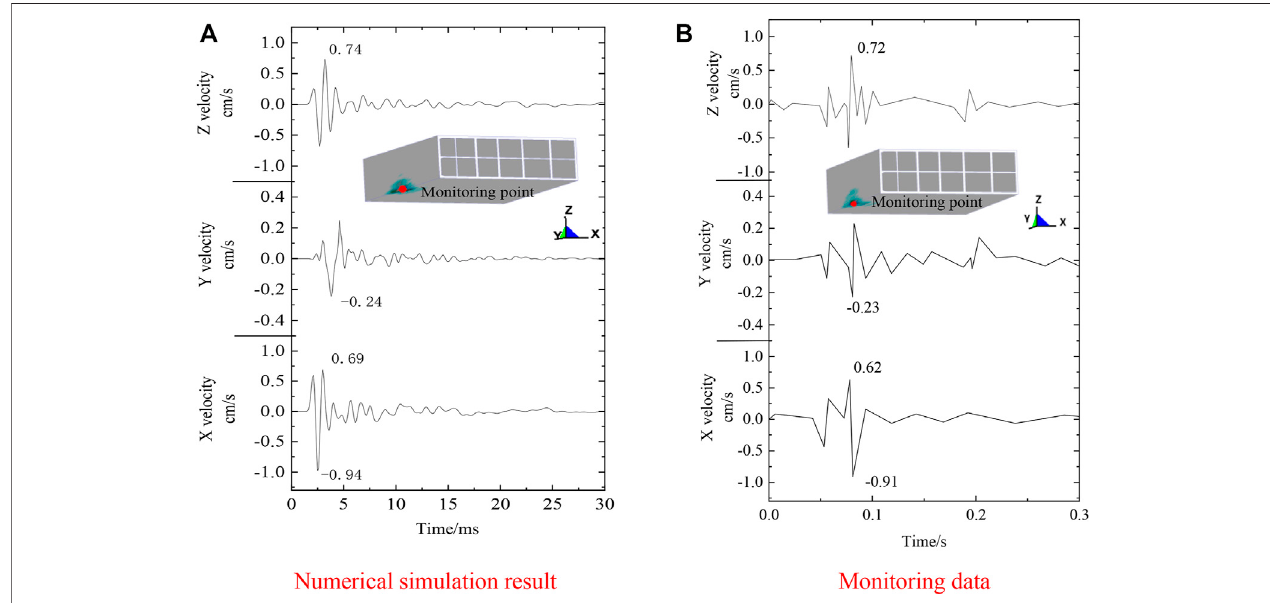
FIGURE 19 | The vibration velocity response of the People ’ s Hall Station on Line 3 induced by blasting construction of Line 4. (A) Numerical simulation resul. (B) Monitoring data.